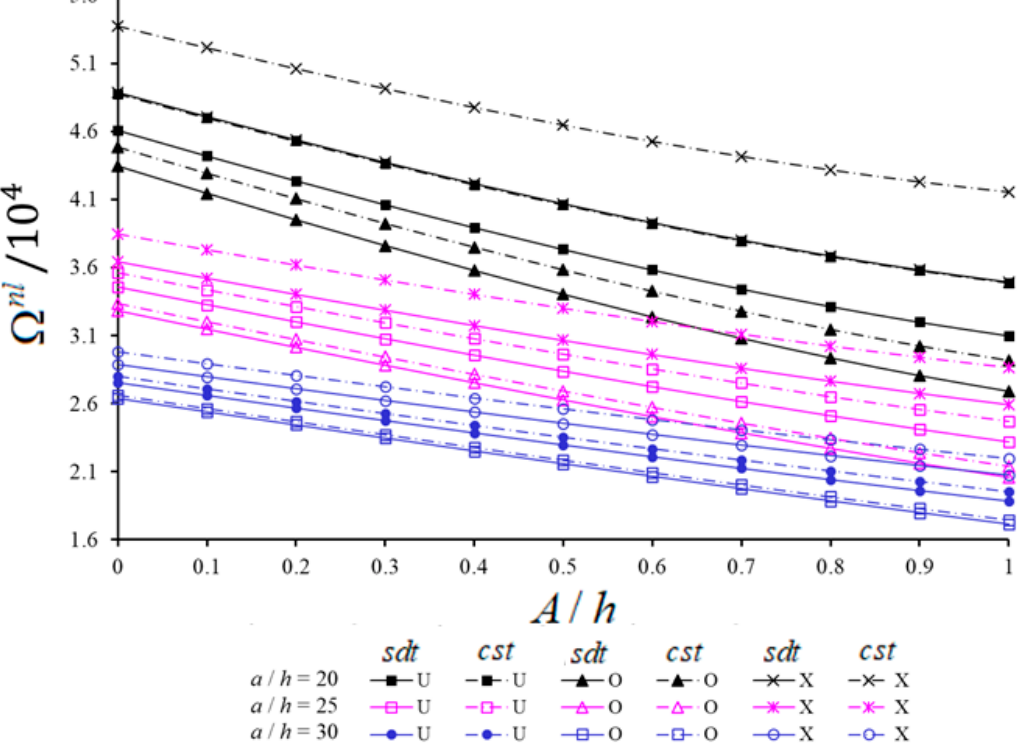
Figure 7. Variation of NLFVs of spherical shells with U, V, O and X patterns within CST and SDT against the A / h for different a / h .